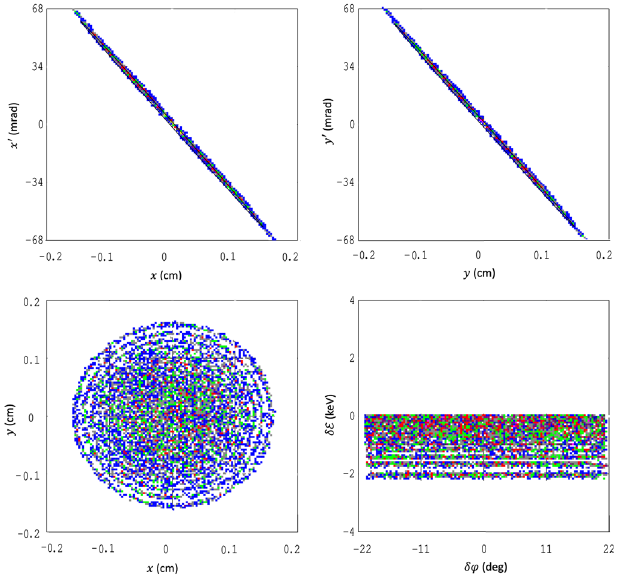
FIG. 23. Beam phase-space in the exit plane of the input aperture. 0.243 mm